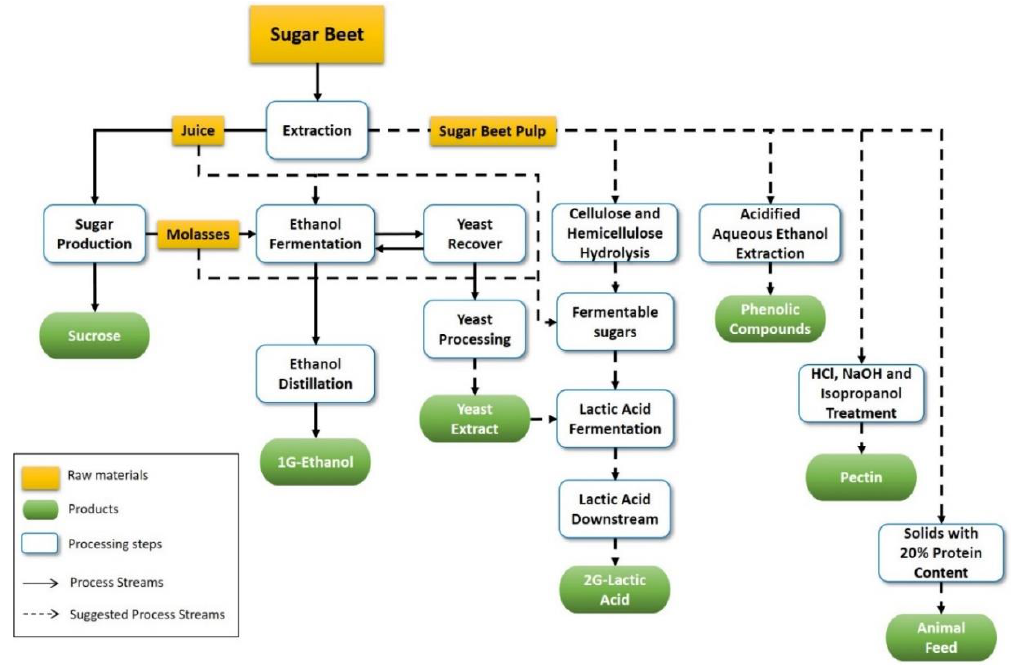
Figure 1. Sugar beet biorefinery: production of sucrose, ethanol, yeast products / yeast extract, lactic acid, phenolic compounds, pectin, and animal feed. 56